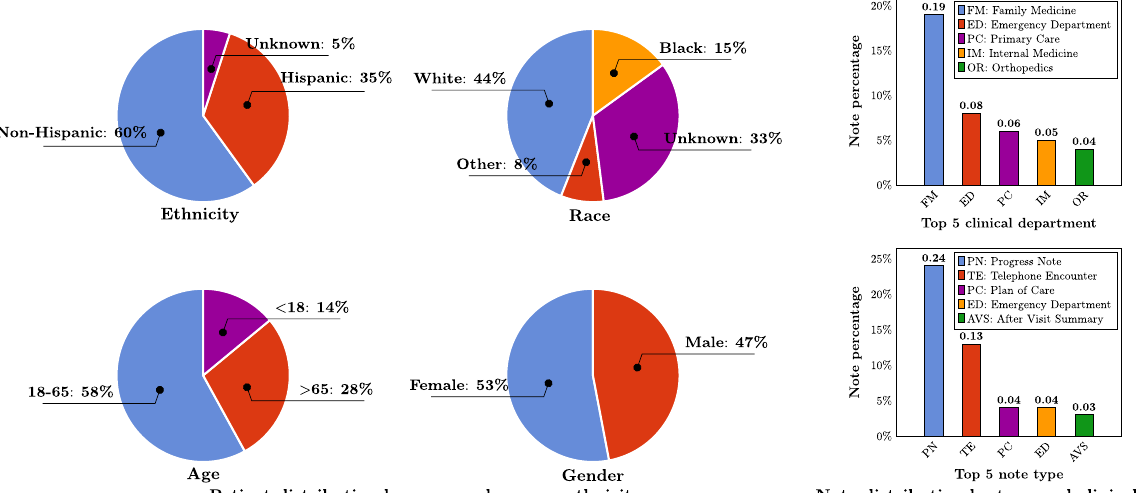
Fig. 1 Patient distribution by age, gender, race, ethnicity; clinical notes distribution by note type, and clinical department. Ages were calculated as of September